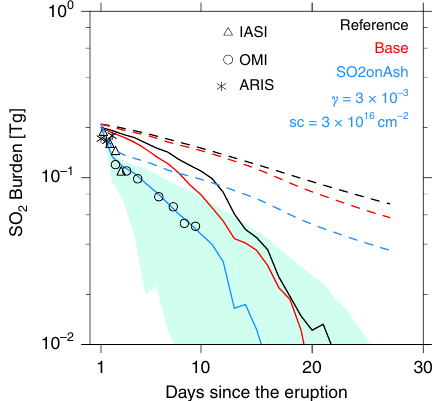
Fig. 2 The volcanic SO2 burden. The satellite observations are shown in symbols and the simulations are shown in lines. IASI is the Infrared Atmospheric Sounding Interferometer. ARIS is Atmospheric Infrared Sounder on board NASA ’ s aqua satellite. OMI is Ozone Monitoring Instrument upper tropospheric and stratospheric SO 2 column data. The dashed lines and solid lines in the same color refer to the same simulations, but the solid lines show the simulated SO 2 burdens counting only the grid cells where SO 2 is above OMI noise level (0.2 Dobson Unit (DU), while the dashed lines show the simulated total SO 2 burden without accounting for observational bias due to signal to noise ratio. The boundaries of the green shaded area are two extreme estimations of simulated SO 2 burden of the SO2onAsh case considering the observational uncertainty. The lower boundary only counts the grid cell with the gridbox average SO 2 higher than the detection limit (a.k.a. fi ve times OMI noise level). The upper boundary assumes the simulated SO 2 occupies only a part of the model grid cell equivalent to the fi ve adjacent pixel threshold of OMI and compares that with the OMI detection limit. The fraction is not smaller than 5 OMI observation pixels. For details of applying observational uncertainties to the modeled results refer to Supplementary Note 1. The descriptions of the model cases are given in Table 1. γ stands for uptake ef fi ciency; sc stands for saturation coverage.